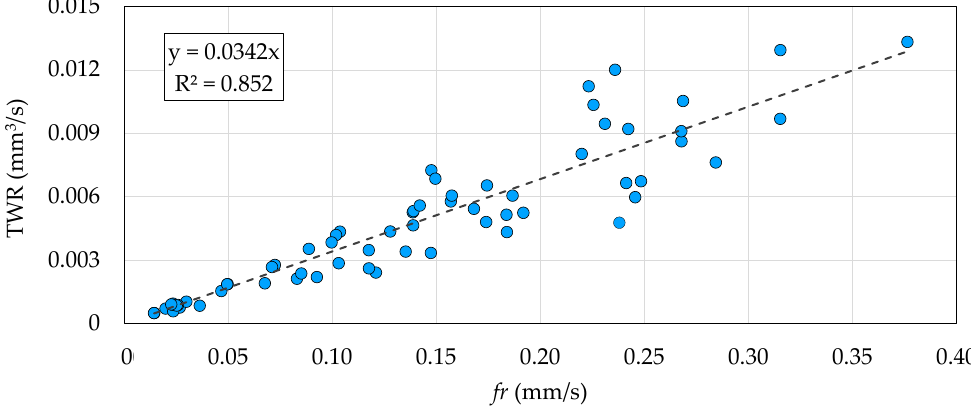
Figure 8. Correlation plot of fr against the TWR. Each data point corresponds to one of the 64 experimental runs. The dashed line is the linear regression line.